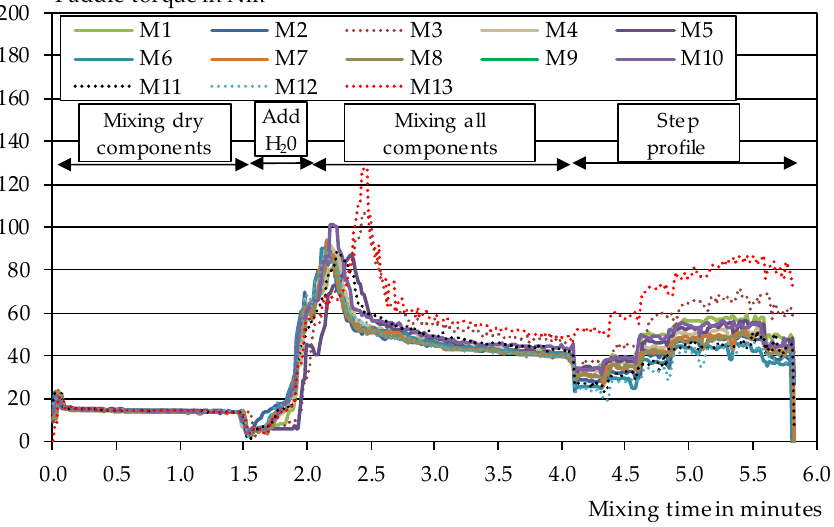
Figure 8. Measured torque from start of mixing for all compounds. Non-extrudable mixtures are shown as dotted lines.